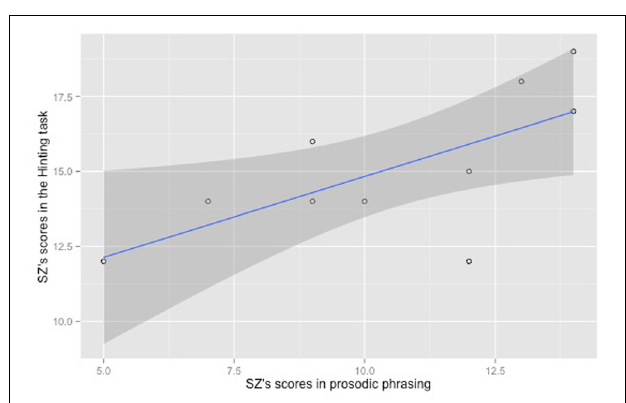
FIGURE 6 | Scatterplot illustrating SZ participants’ scores in prosodic phrasing vs. their scores in the hinting